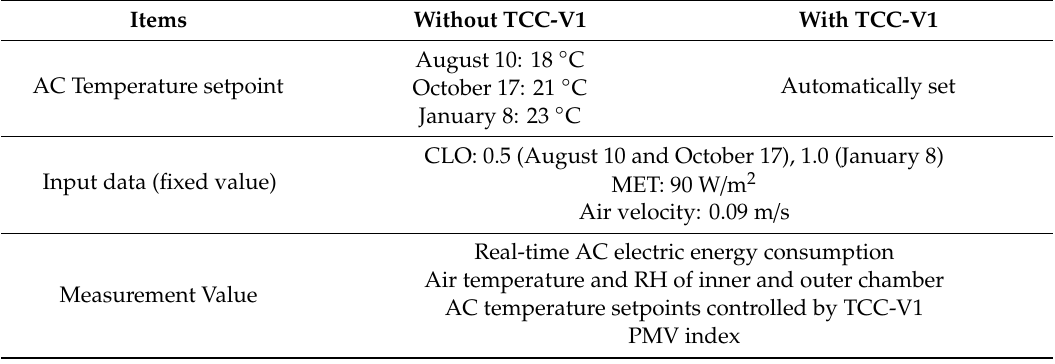
Table 3. Conditions for experimental performance evaluation.